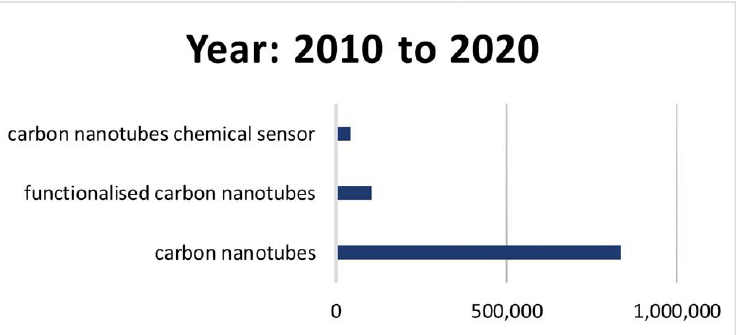
Figure 10. Number of publications with the specific keywords from the year 2010 to 2020. Reprinted with permission from Reference